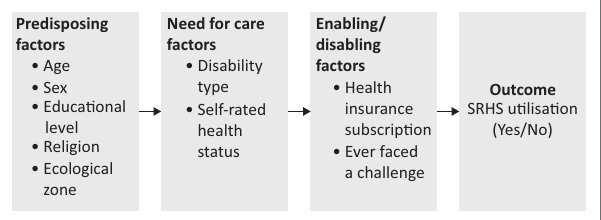
FIGURE 1: Conceptual